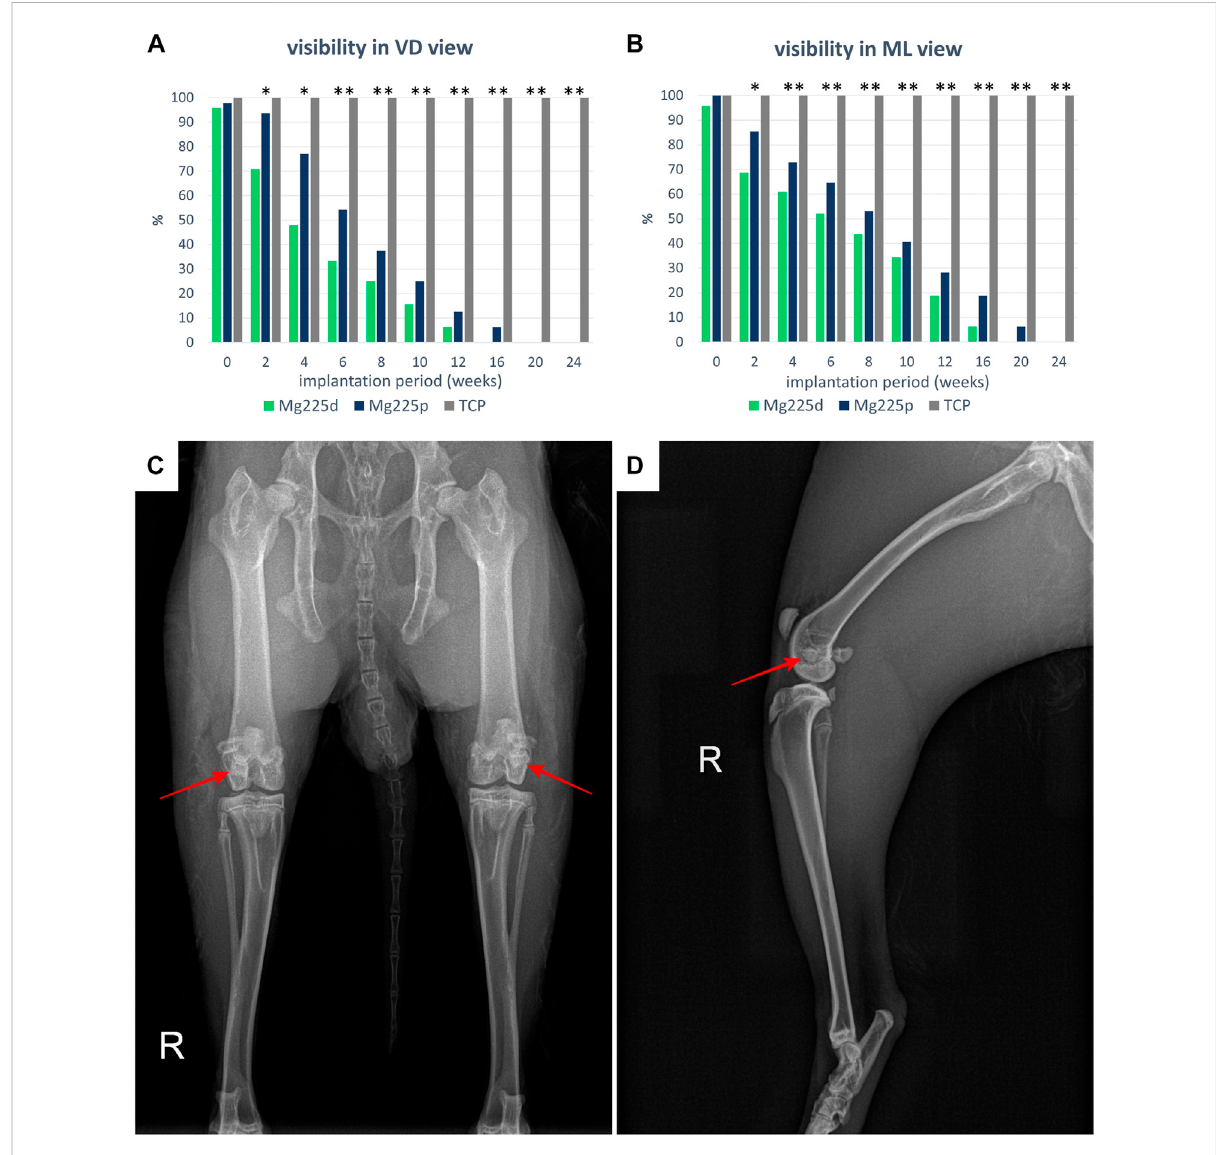
FIGURE 3 Visibility of the scaffolds in the X-ray in (A) ventrodorsal (VD) and (B) mediolateral (ML) view. Signi fi cant differences ( p < 0.05) are marked with *: Mg225d — TCP, **:CMPCs — TCP. (C) VDX-ray view ofthehind limbs directly after surgery withMg225d implanted intheleftand Mg225p intheright femoral condyle. (D) ML X-ray view of the right hind limb directly after surgery with implanted Mg225p